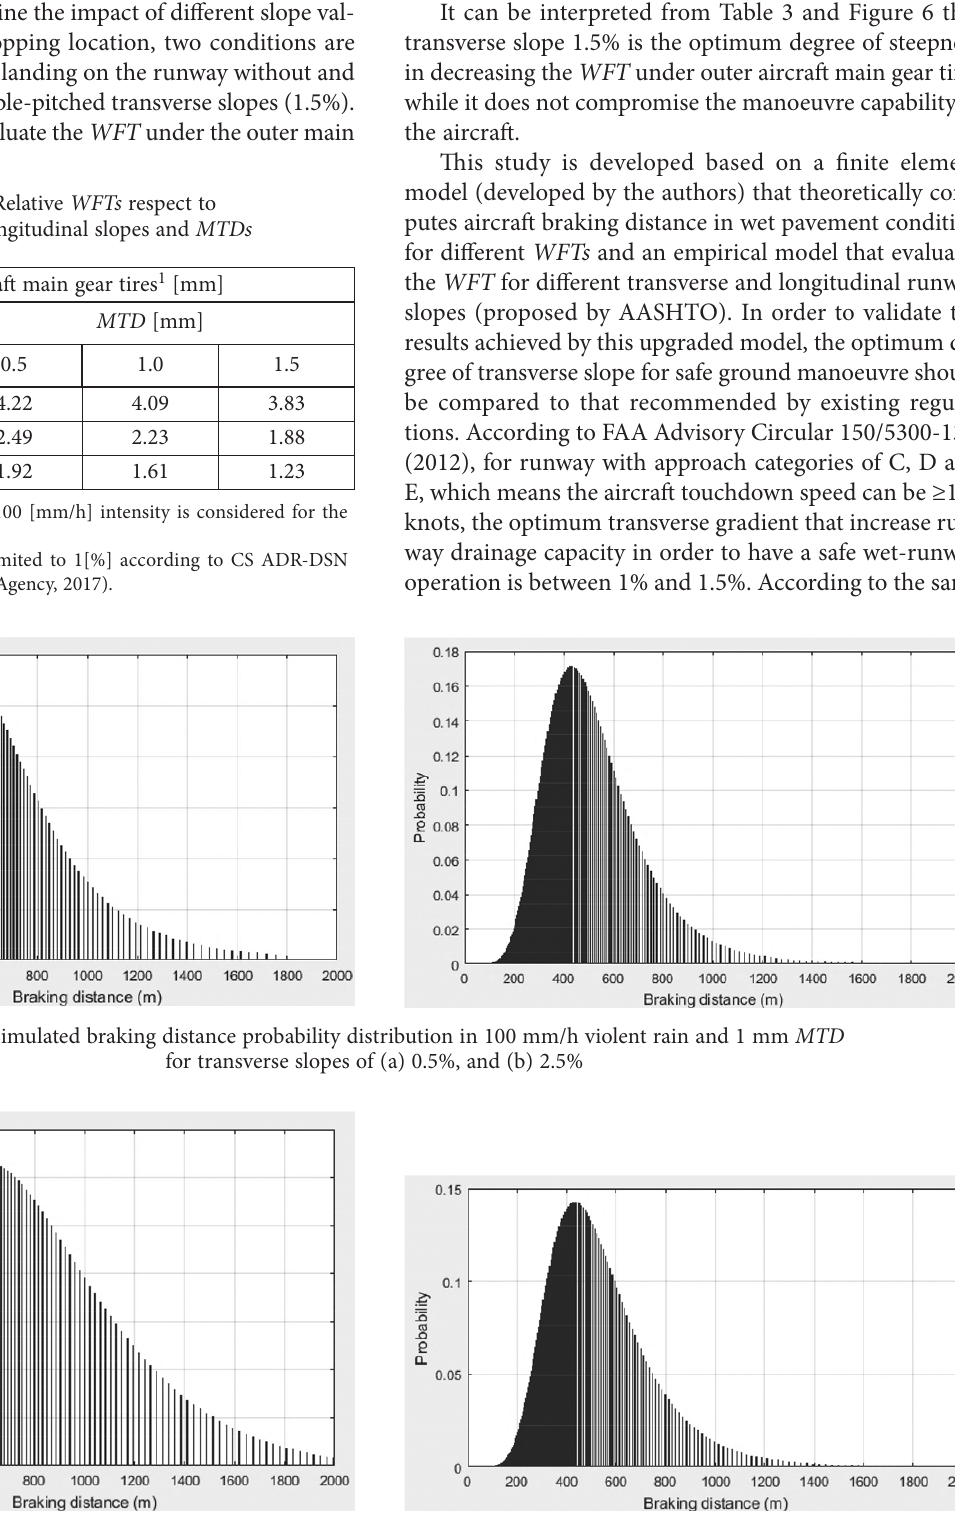
Figure 6. Simulated braking distance probability distribution in 100 mm/h violent rain and 1 mm MTD for (a) no transverse slope (0.1%), and (b) 1.5% transverse